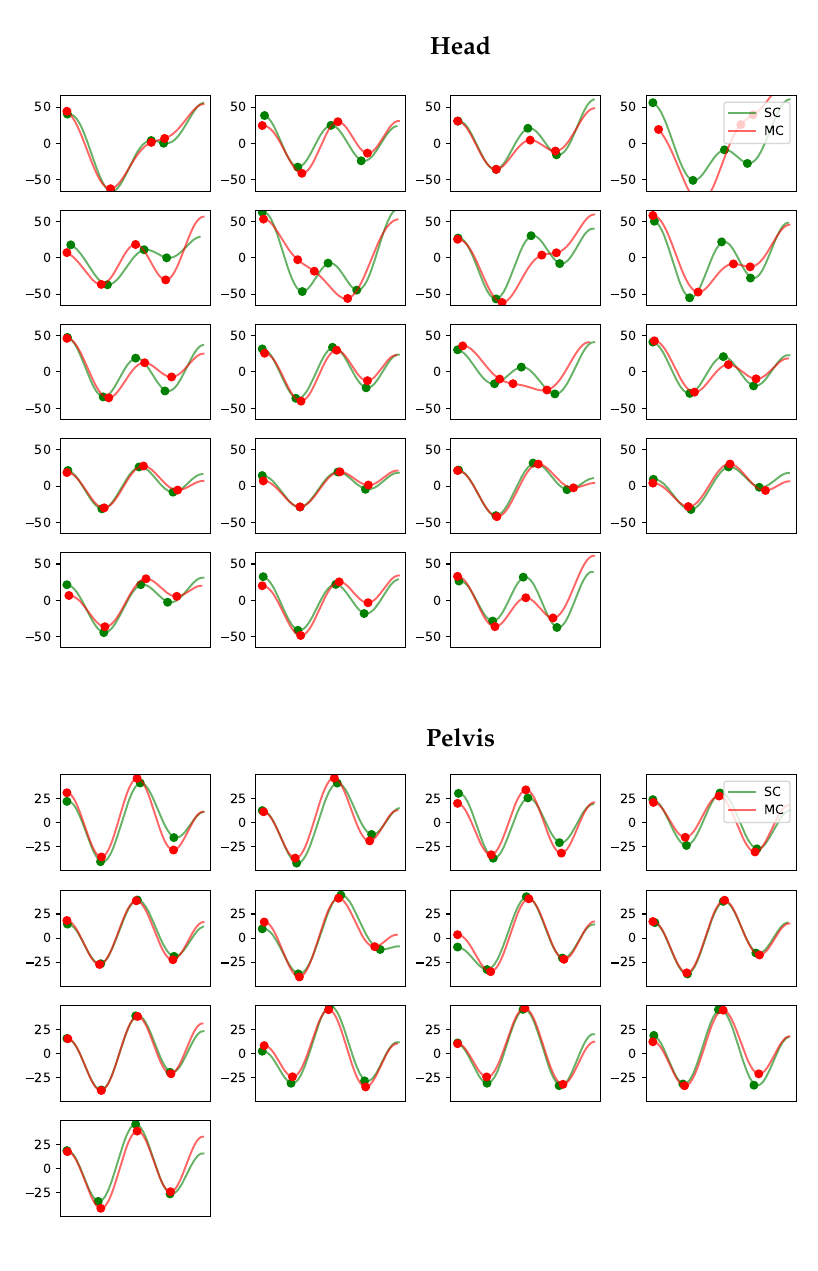
Figure A15. Vertical displacement signals per stride for the head and pelvis for horse 16. Each subplot contains the matched stride segments for the single-camera markerless system (SC) in green and the multi-camera marker-based system (MC) in red. The y-axis shows the vertical displacement in millimeters. The four dots on each curve indicate the positions of the two peaks and two valleys extracted using the approach in Section